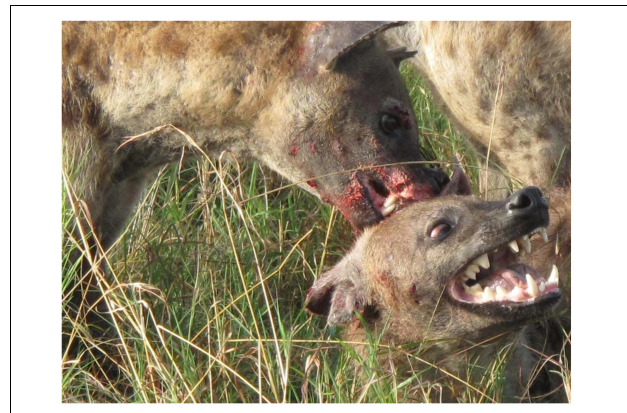
FIGURE 1 | Damaging physical contests between competing high-ranking female coalitions during a period of social instability (coup). Photo: MLE and